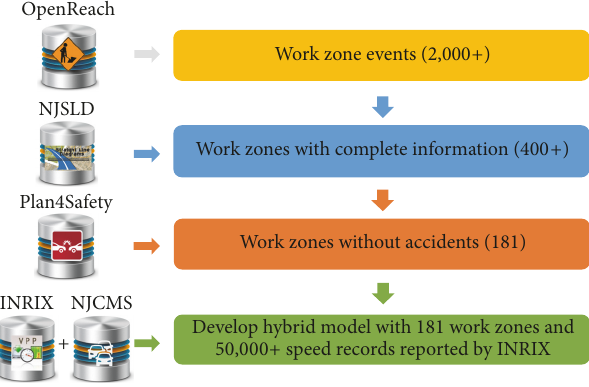
Figure 1: Data processing